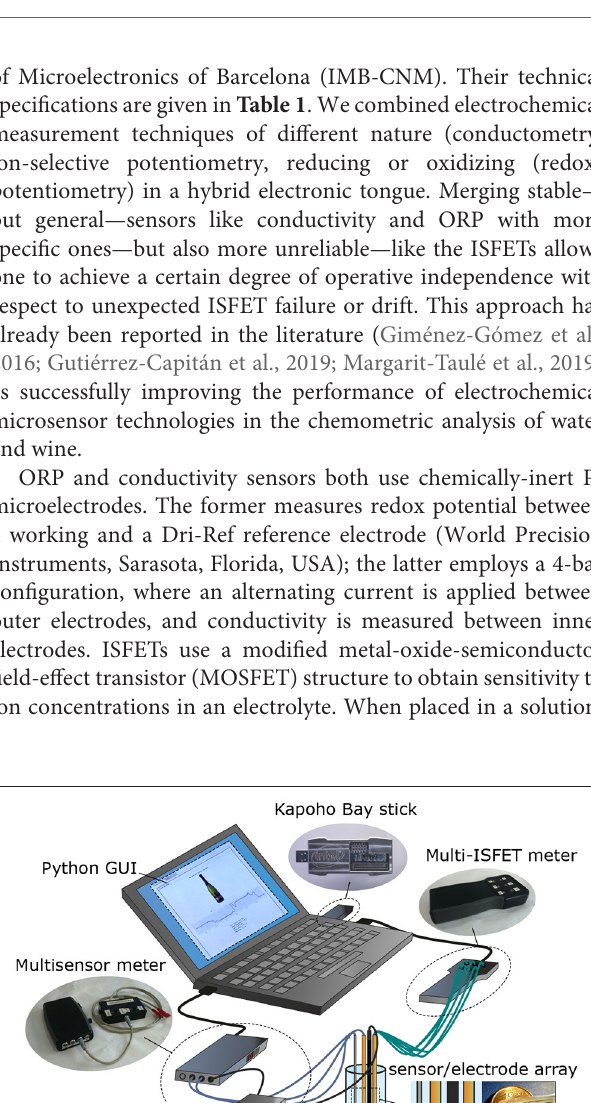
temperature Pt-100 (a), 2 Pt × × reference electrodes (c), 6 × ×